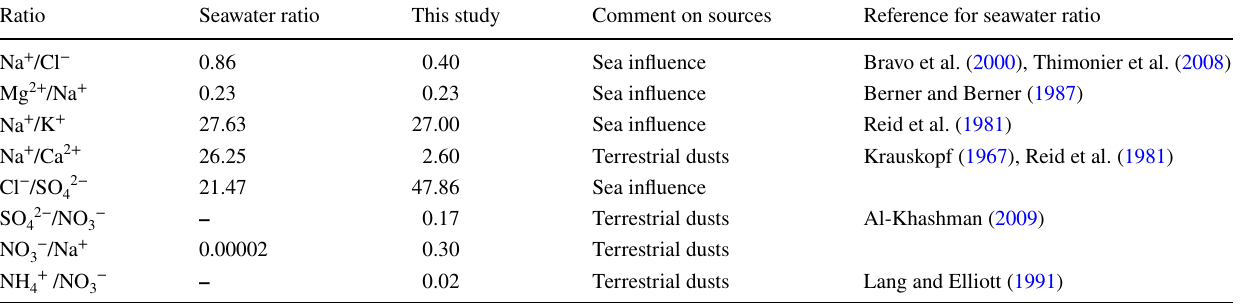
Table 4 Comparison of the ratio values of precipitation ions with the corresponding seawater